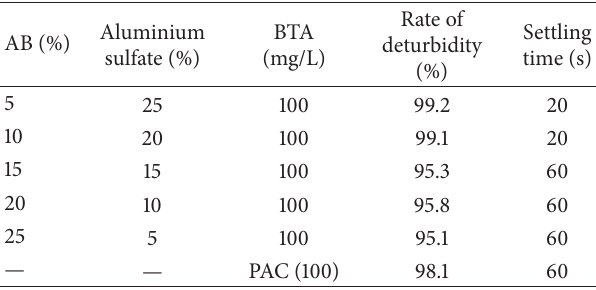
Table 2: The influence of additives on coagulation behaviors of BTA while PAC content was 10% (200NTU diatomite suspension).